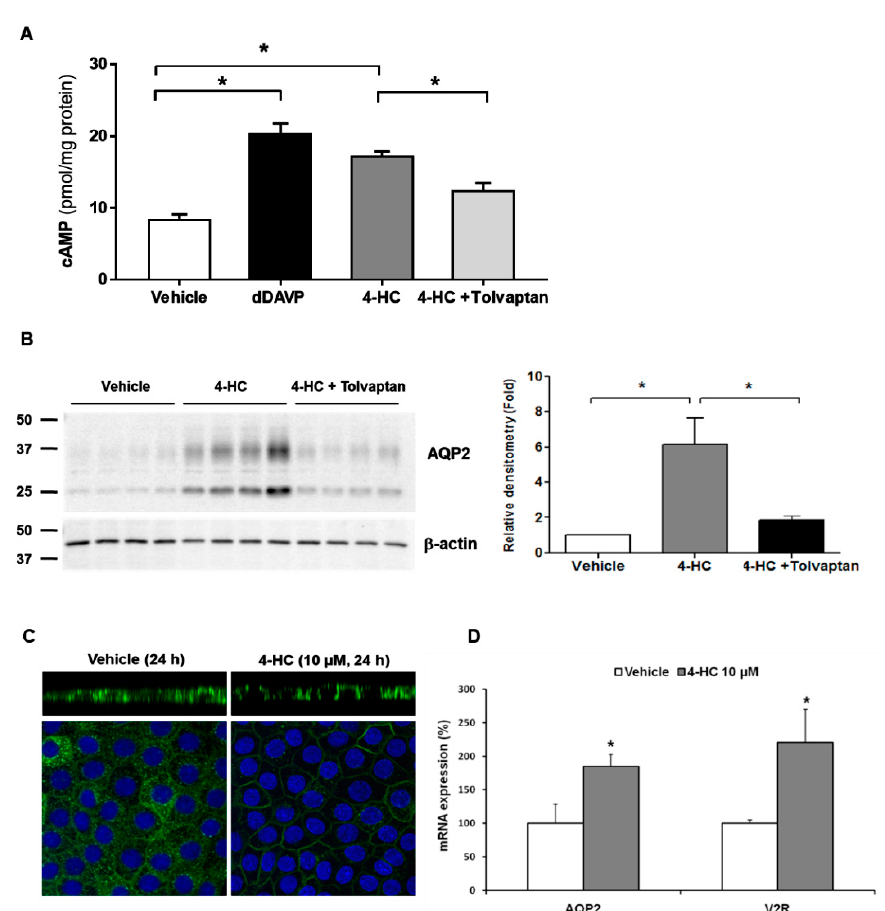
Figure 1. In vitro action of 4-hydroperoxycyclophosphamide (4-HC) for aquaporin-2 (AQP2) upregulation in inner medullary collecting duct (IMCD) cells. The effect of 4-HC, the active hepatic metabolite of cyclophosphamide, was tested in IMCD suspensions and primary cultured IMCD cells. ( A ) Intracellular cAMP levels were measured by ELISA in IMCD suspensions after treatment with vehicle, 10 nM dDAVP, 10 µM 4-HC, and 10 µM 4-HC + 100 nM tolvaptan at 37 °C for 30 min. ( B ) Immunoblot analysis of AQP2 was performed from primary cultured IMCD cells treated with 4-HC with and without tolvaptan. ( C ) Immunofluorescence microscopy for AQP2 in primary cultured IMCD cells shows that AQP2 targeting was induced to the plasma membrane (apical and lateral membrane) by 4-HC treatment (X-Z images). ( D ) Quantitative polymerase chain reaction data show that AQP2 and vasopressin-2 receptor (V2R) mRNA expression were increased by 4-HC treatment. Each bar represents mean ± SD. * p < 0.05 vs. control by the Mann–Whitney U-test. Adapted from Ref. [32] with permission.